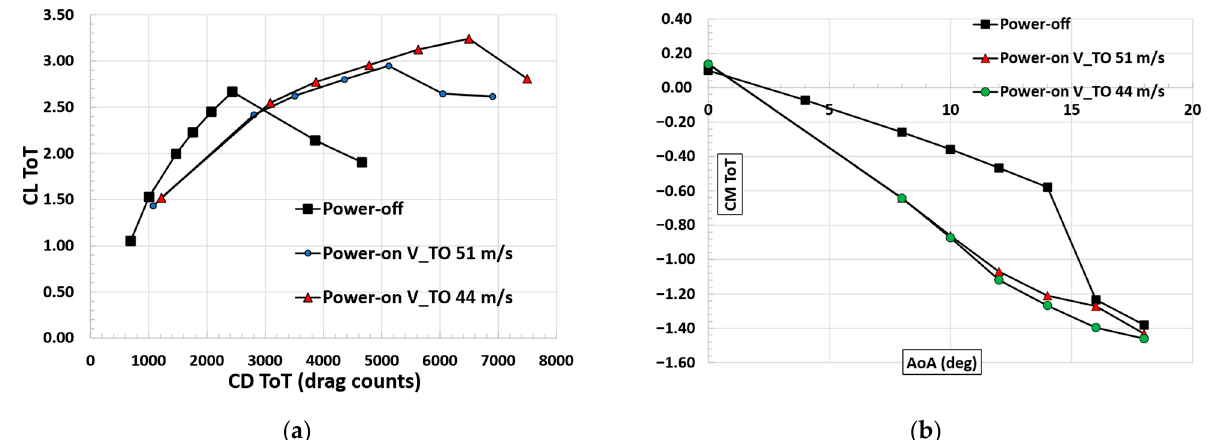
Figure 24. Total lift coefficient curves for power-off and power-on take-off conditions, V TO = 44 m/s and V TO = 51 m/s, Re = 5.7 × 10 6 , J TIP = 0.78, rpm TIP = 1600, J DEP = 0.89, rpm DEP = 2000.